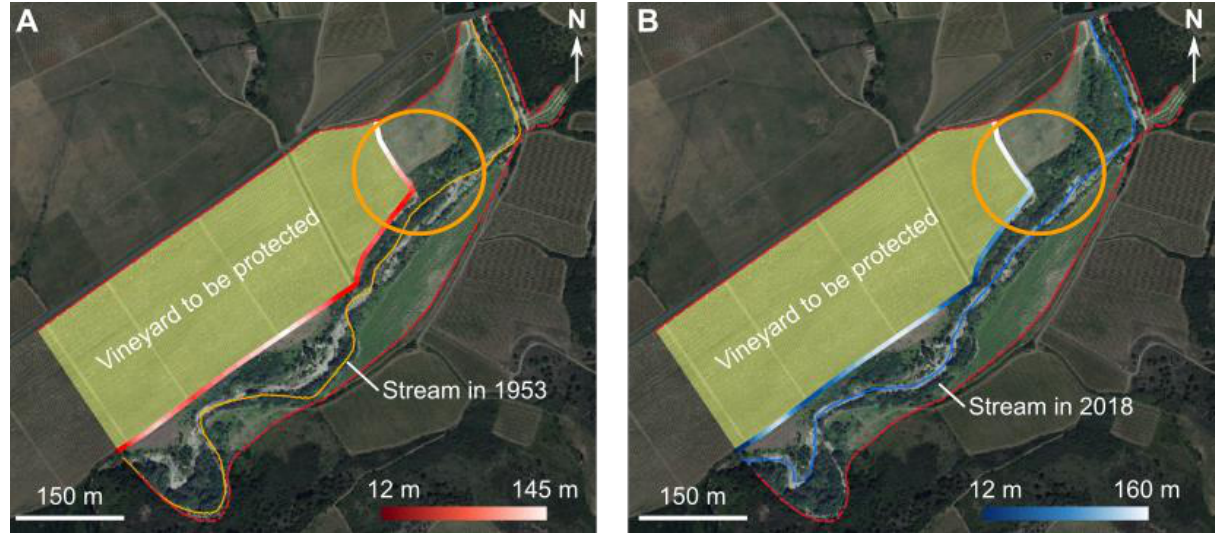
Figure 11. Indicator 2. Distance between the edge of the vineyard and the 1953 active channel ( A ); distance between the edge of the vineyard and the 2018 active channel ( B ) of the Clamoux River.